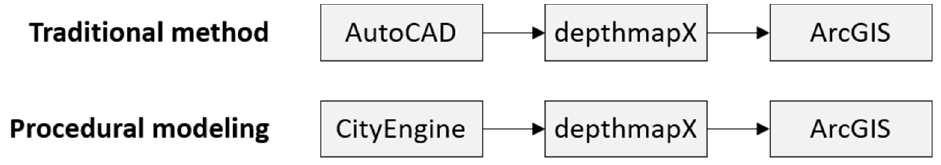
Figure 5. Two methods of infrastructure installation planning.